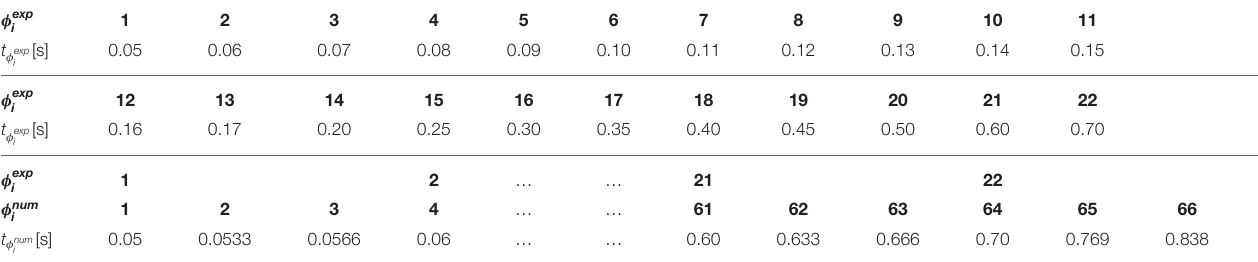
TABLE 1 | Pulsatile turbulent flow downstream a bioprosthetic heart valve: division of the pulse period T in N exp 8 = 22 intervals and N num 8 = 66 intervals. φ exp